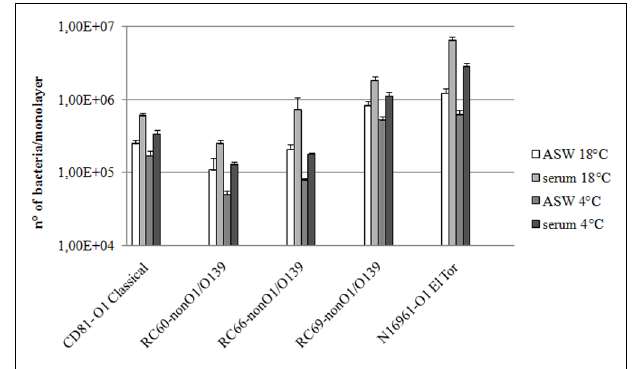
FIGURE 1 | Vibrio cholerae strains association to (18 ◦ C) and adhesion with (4 ◦ C) hemocyte monolayers. All the experiments were performed in the presence and in the absence of hemolymph serum, after 60 min of incubation. P < 0.05.